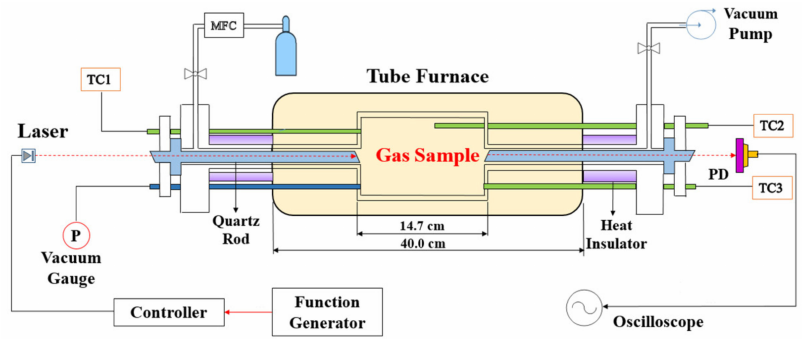
Figure 1. Schematic diagram of the measurement in the high-temperature tube